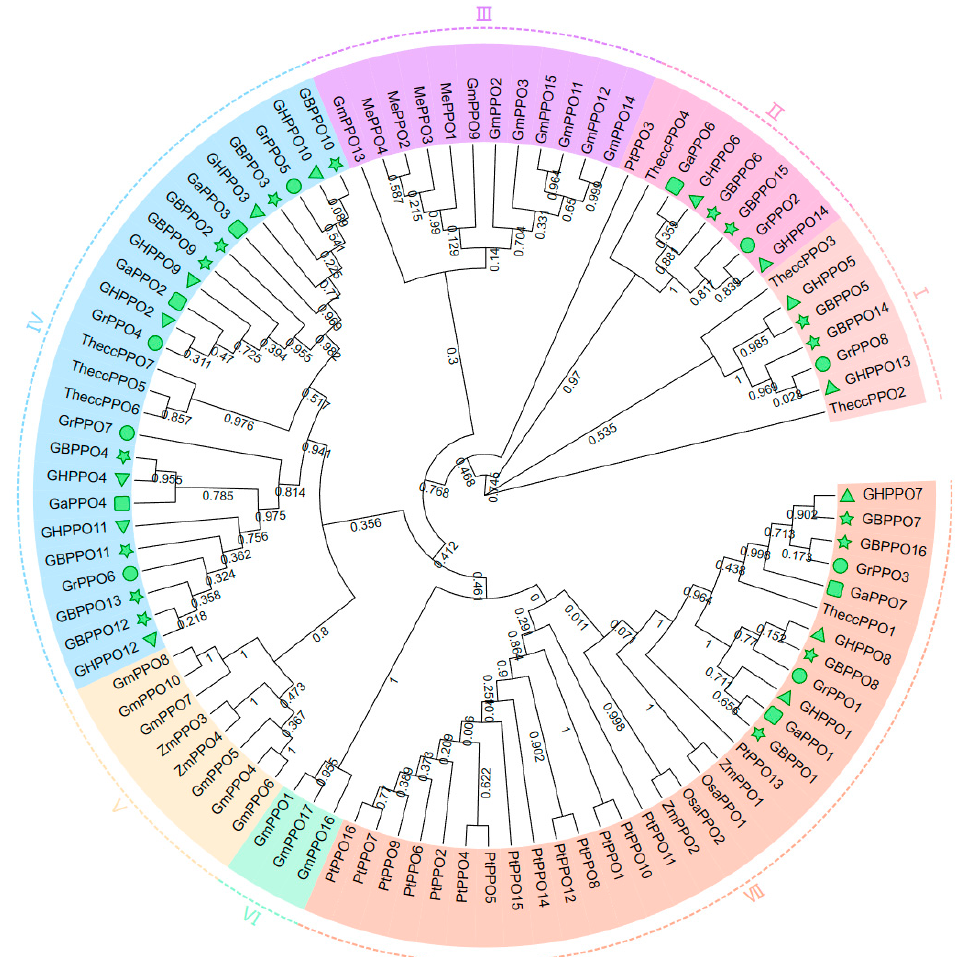
Figure 2. Phylogenetic tree of PPO genes among G. arboreum (GaPPO), G. raimondii (GrPPO), G. hirsutum (GhPPO), G. barbadense (GbPPO), G. max (GmPPO), P. trichocarpa (PtPPO), O. sativa (OsaPPO), Z. mays (ZmPPO), M. truncatula (MePPO), and T. cacao (TheccPPO).